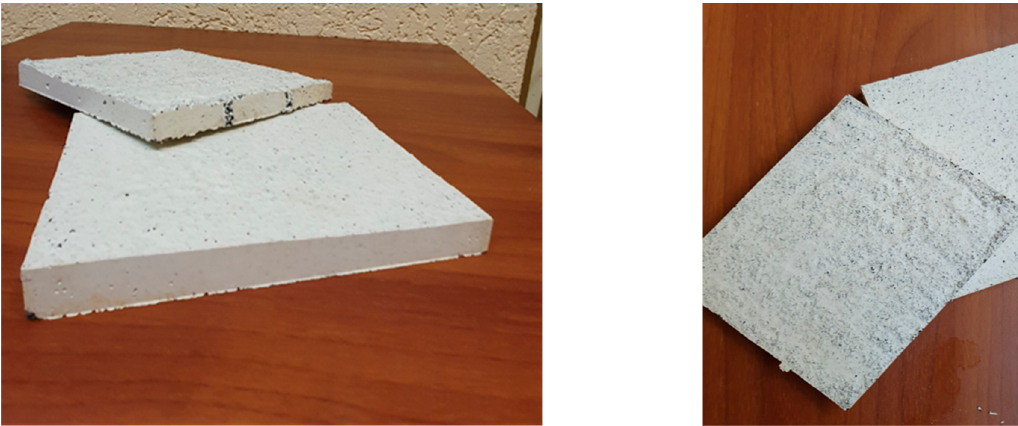
Figure 5. Tiles with rubber crumb (side and top view).